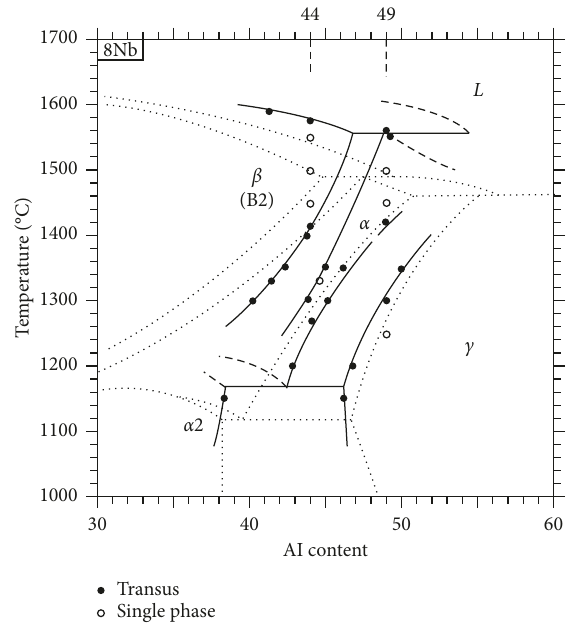
Figure 6: Quasi-phase diagram of TiAl-8Nb-xO [55].